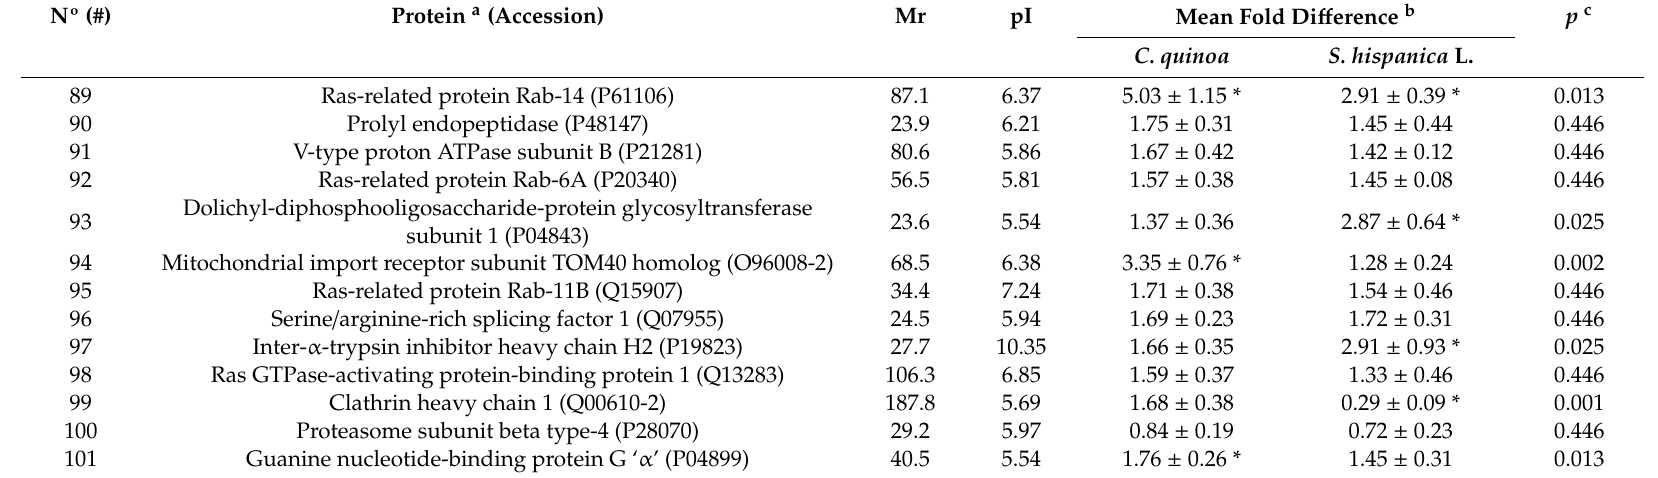
a Molecular mass (Mr, Da) and Swissprot accession name; b The fold change of each protein is calculated as ratio between emPAI values, stress / control; emPAI = 10PAI - 1 where PAI is defined as PAI = N obsd / N obsbl and N obsd and N obsbl are the number of observed peptides per protein and the number of observable peptides per protein, respectively; c p values calculated for statistical comparison between cell cultures exposed to extracts from C. quinoa or S. hispanica L; * Statistical ( p < 0.05) comparison between control cultures and those exposed to extracts from C. quinoa or S. hispanica